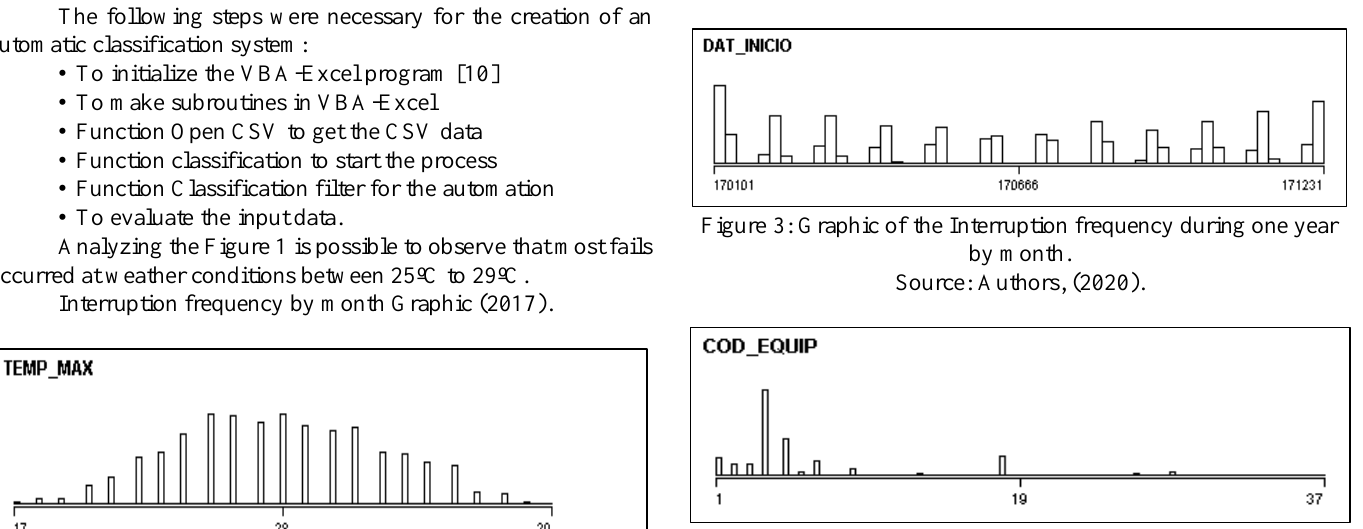
Figure 4: Graphic of the Interruption frequency during by equipment based on Table